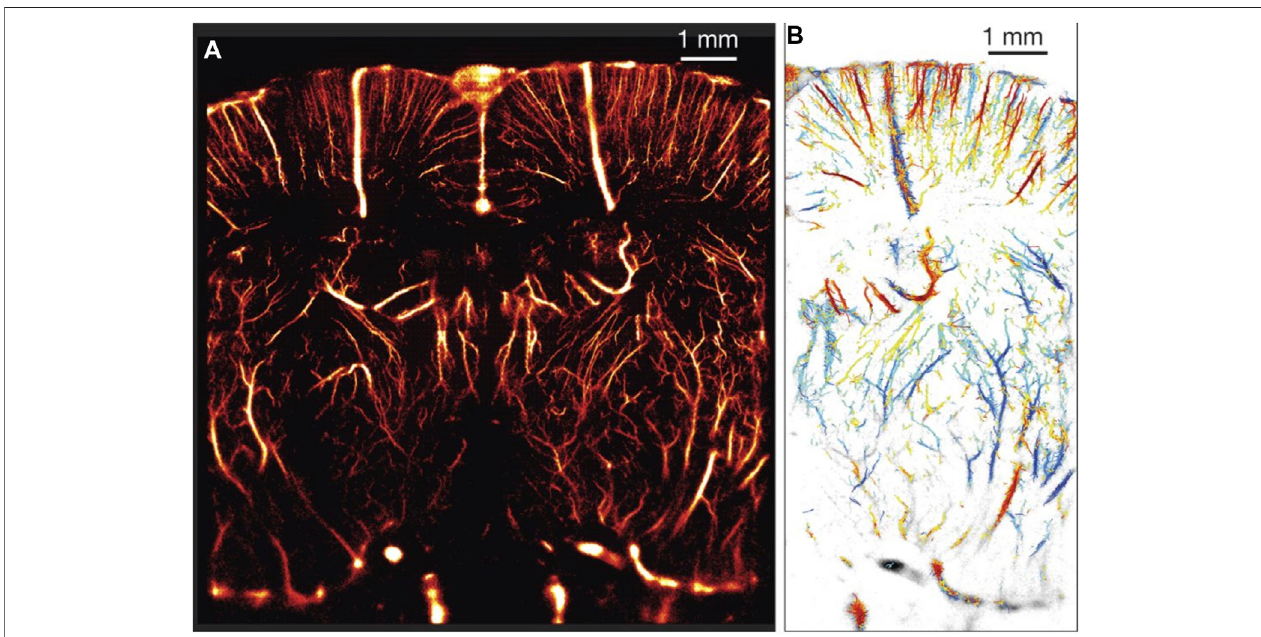
FIGURE 4 | (A) An example of ULM applied in a rat brain through a thinned, intact skull providing a resolution of 10 µm × 8 µm in depth and lateral direction, respectively. (B) In-plane velocity map from parts of the vessel from panel A. Scale bar runs from − 14 mm/s (blue) to +14 mm/s (red). Reprinted from [135] with permission from the authors and Nature Publishing